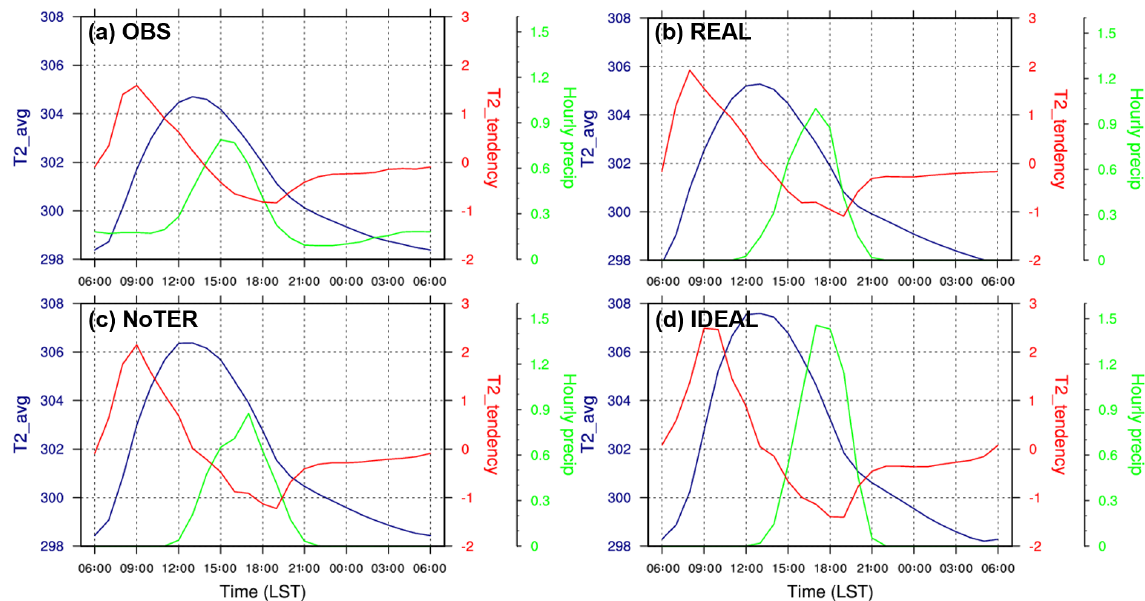
Figure 7. The average of 2m temperature (T2_avg), 2m temperature tendency (T2_tendency, temperature difference between two neigh- boring hours), and hourly rainfall accumulation over the island based on (a) gauge observations, (b) the REAL experiment, (c) the NoTER experiment, and (d) the IDEAL experiment. Horizontal colored lines indicate means over all